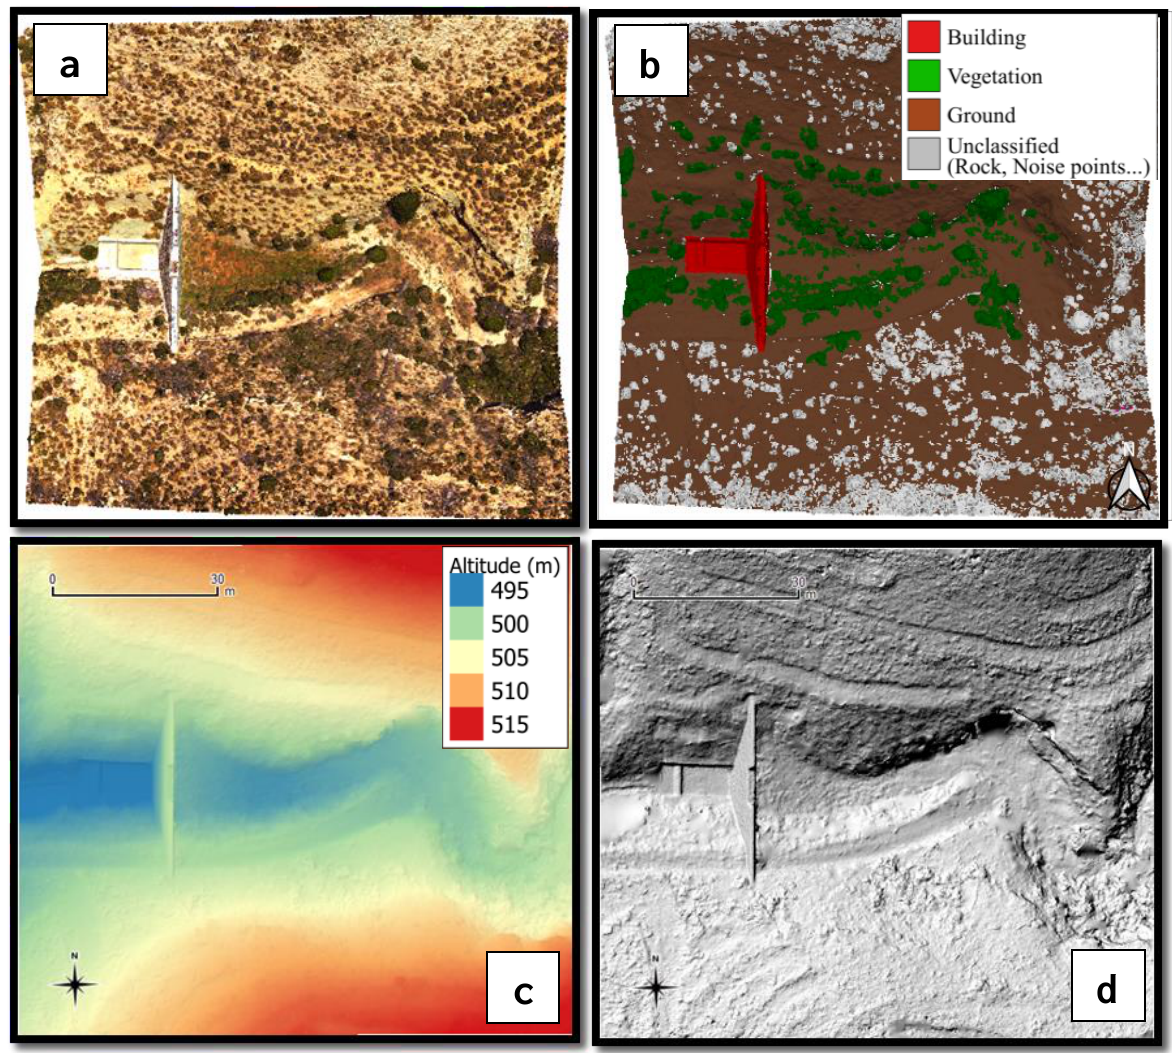
Figure 4. Cartographic products obtained in the aerophotogrammetric survey for Conejo (number 1) check dam (Sierra de Los Donceles forest, Castilla La Mancha, Spain): ( a ) 3D point cloud; ( b ) Classified point cloud; ( c ) Digital Terrain Model (DTM); ( d ) Shaded DTM.